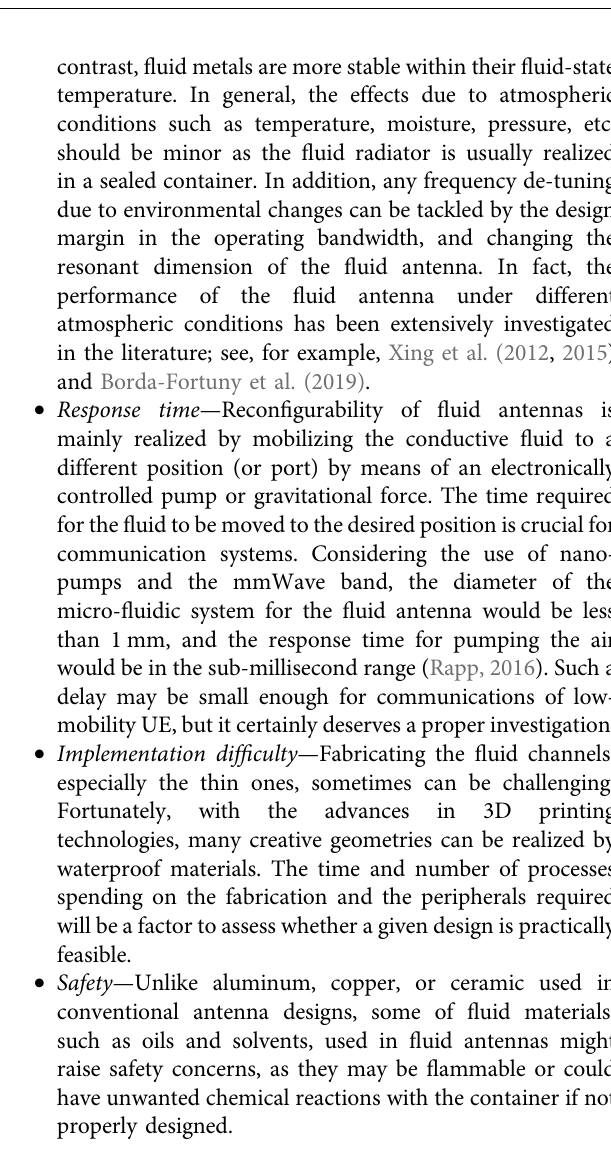
Frontiers in Communications and Networks |